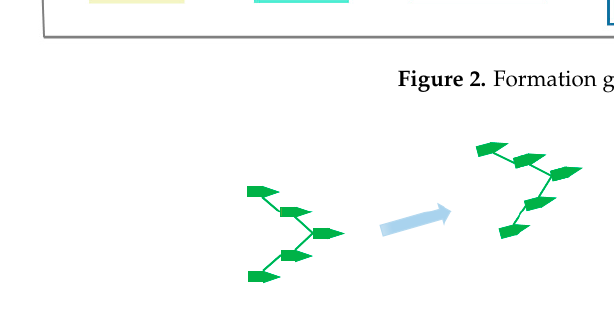
Figure 3. Formation maintenance.